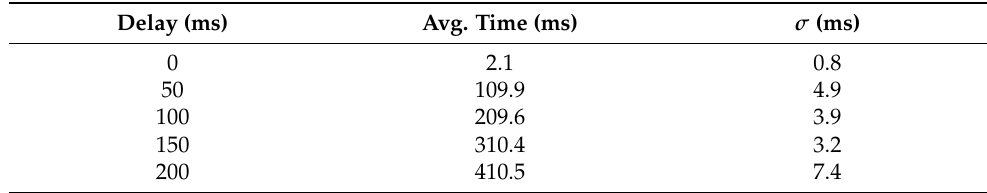
Table 2. HTTP/3 adoption rate and connection establishment time with external delay settings. (Alt-Svc).